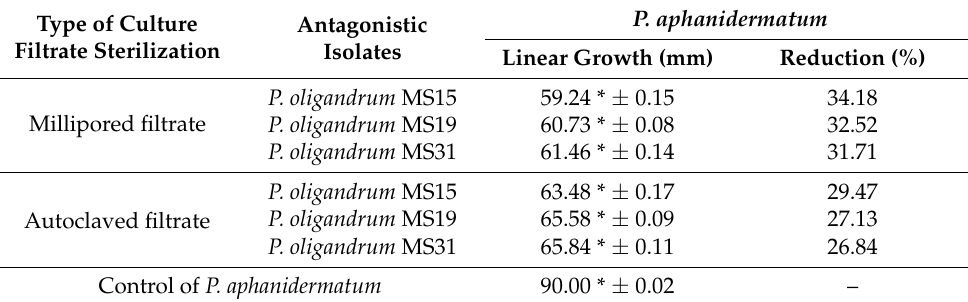
Table 2. Effect of half-strength culture filtrates of P. oligandrum isolates (MS15, MS19 and MS31) on mycelial linear growth of the pathogenic P. aphanidermatum .